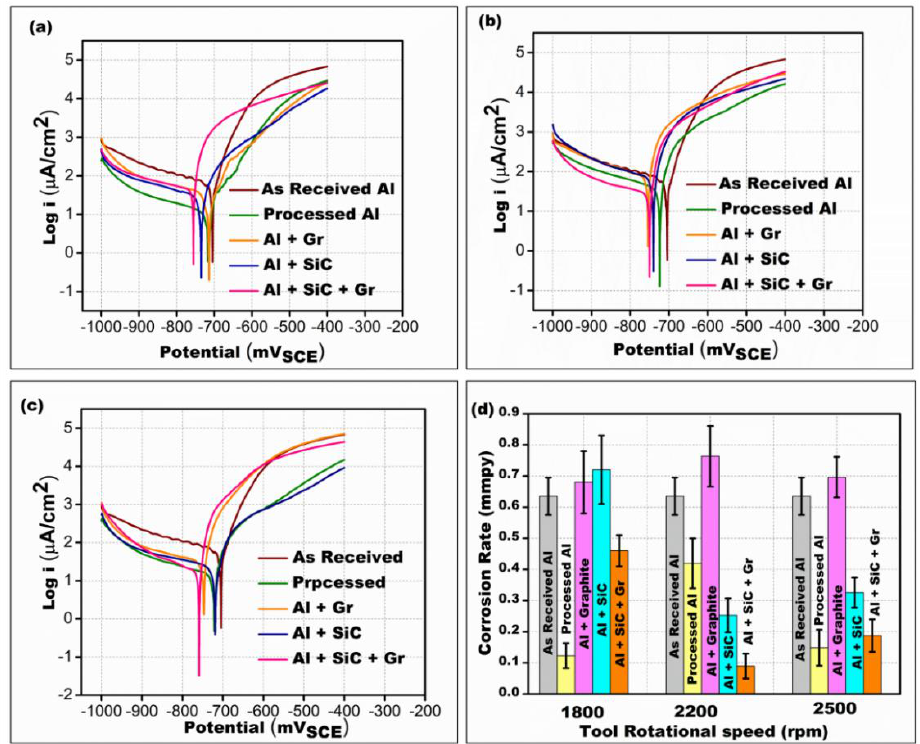
Figure 6 . Linear potentiodynamic polarization curves obtained at ( a ) 1800 rpm ( b ) 2200 rpm ( c ) 2500 rpm; ( d ) corrosion rate. Graphite is abbreviated as Gr.